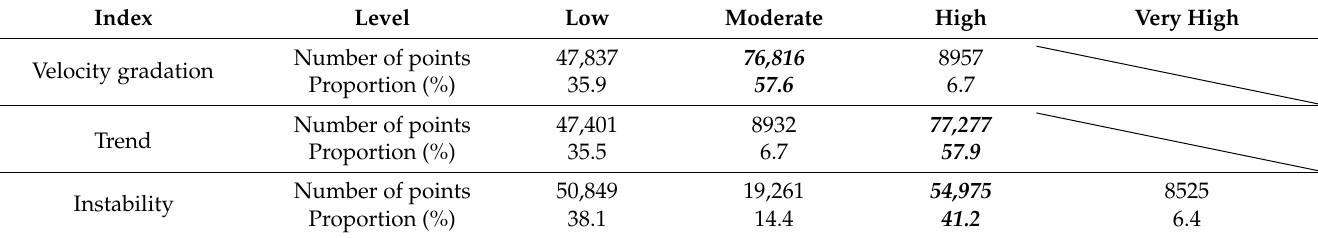
Figure 11. The ( a ) deformation velocity map. ( b , c ) results of deformation velocity gradation, trend estimation, and instability of the two regions with concentrated deformation areas. Table 4. Basic information and assessment results of the deformation regions in Dongguan